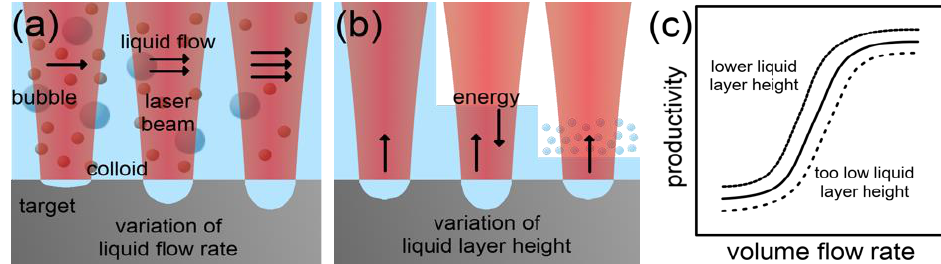
Figure 11. Illustration of the effect of the liquid flow rate ( a ) and of the liquid layer height ( b ) on the productivity in the laser ablation of metals in liquids. The diagram in ( c ) demonstrates relative effects of different liquid layer heights on the dependence of the productivity on the volume flow rate. In ( c ), both axes scale linearly. The trends shown in the diagram represent the interpretation of the combined results of the discussed literature in Section 2.2.1. In ( c ), the dashed line shows the effect of lower liquid layer height on the productivity, and the dashed line shows the effect of a too low liquid layer height compared to the solid line, respectively. Reprinted with permission from [66].